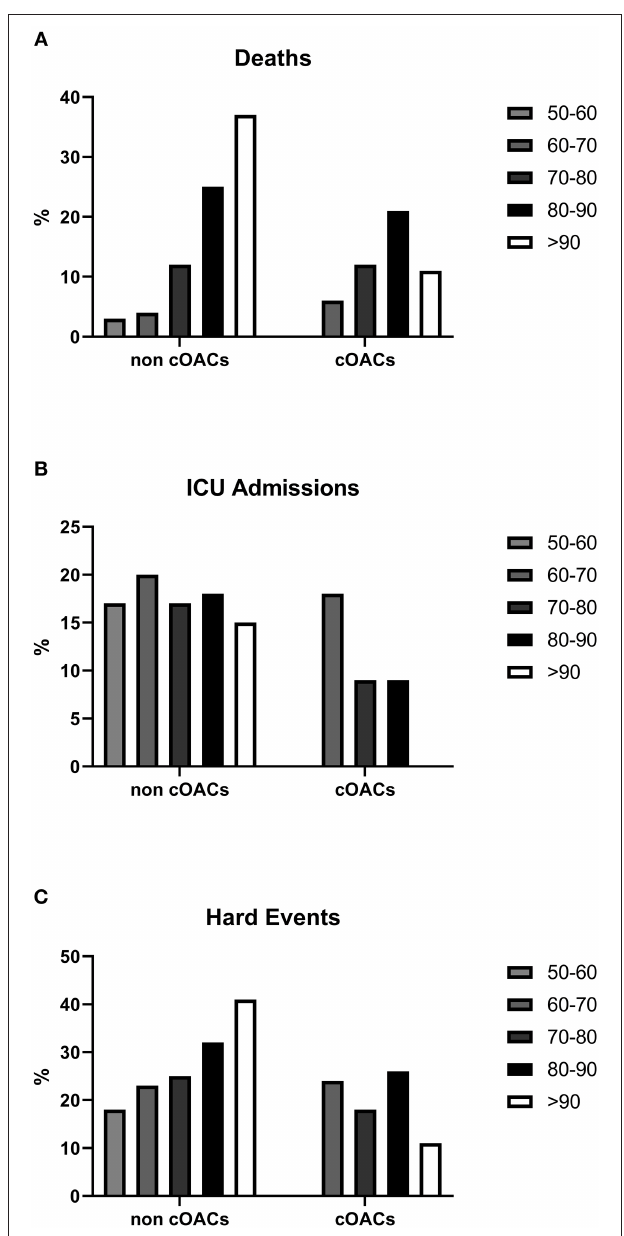
FIGURE 2 | (A) Death rates in non-cOACs and cOACs COVID-19 patients. (B) ICU admission rates were lower in non-cOACs than cOACs COVID-19 patients. (C) CHE (death and ICU admission) rates were similar in non-cOACs and cOACs COVID-19